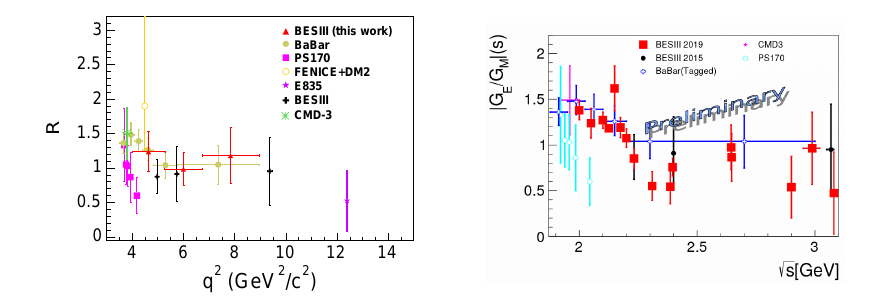
Figure 3. The R = | G E / G M | of M p ¯ p between 2.0 and 3.0 GeV via (left) ISR process and (right) scan method, and comparison with other experiments.